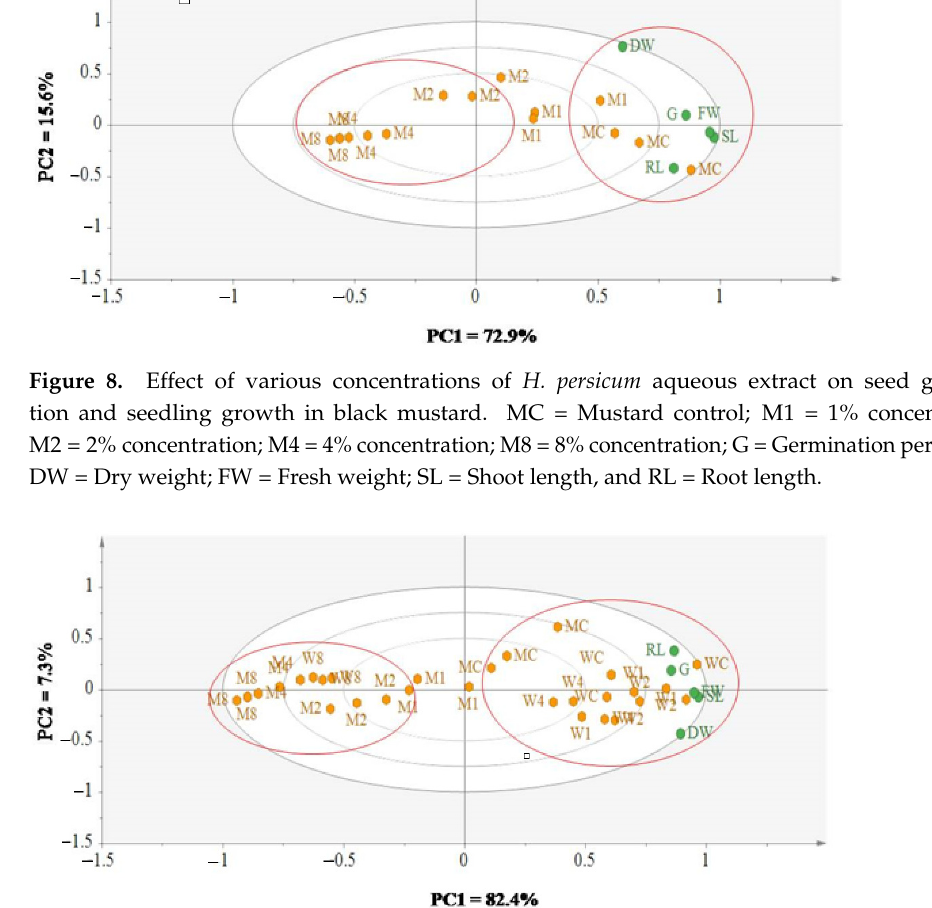
Figure 9. Effect of various concentrations of H. persicum aqueous extract on seed germination and seedling growth in wheat and black mustard. WC = wheat control; MC = Mustard control; W1 = 1% concentration on wheat; W2 = 2% concentration on wheat; W4 = 4% concentration on wheat; W8 = 8% concentration on wheat; M1 = 1% concentration; M2 = 2% concentration; M4 = 4% concentration; M8 = 8% concentration on black mustard; G = Germination percentage; DW = Dry weight; FW = Fresh weight; SL = Shoot length, and RL = Root length.